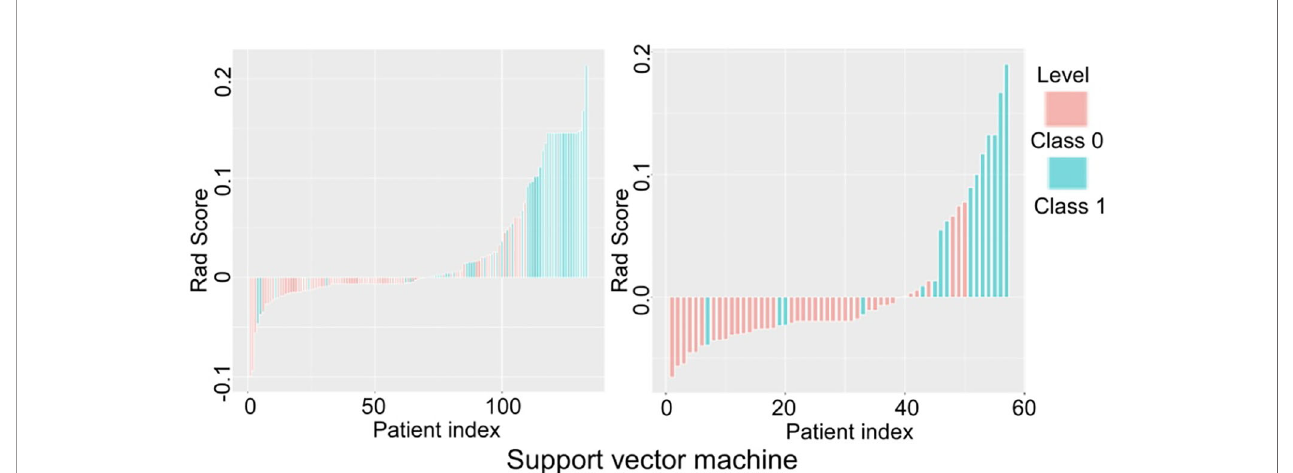
FIGURE 6 | Veri fi cation and comparison of the support vector machine model in predicting low and high grade renal cell carcinoma in the training and testing set. In the training set, the true negative rate (speci fi city) was 76.5% (62/81) for predicting grade I-II clear cell renal cell carcinoma (ccRCC), and the true positive rate (sensitivity) was 84.6% (44/52). In the testing set, the true negative rate was 85.4% (35/41) for predicting grade I-II ccRCC and 75% (12/16) for predicting grade III-IV ccRCC.